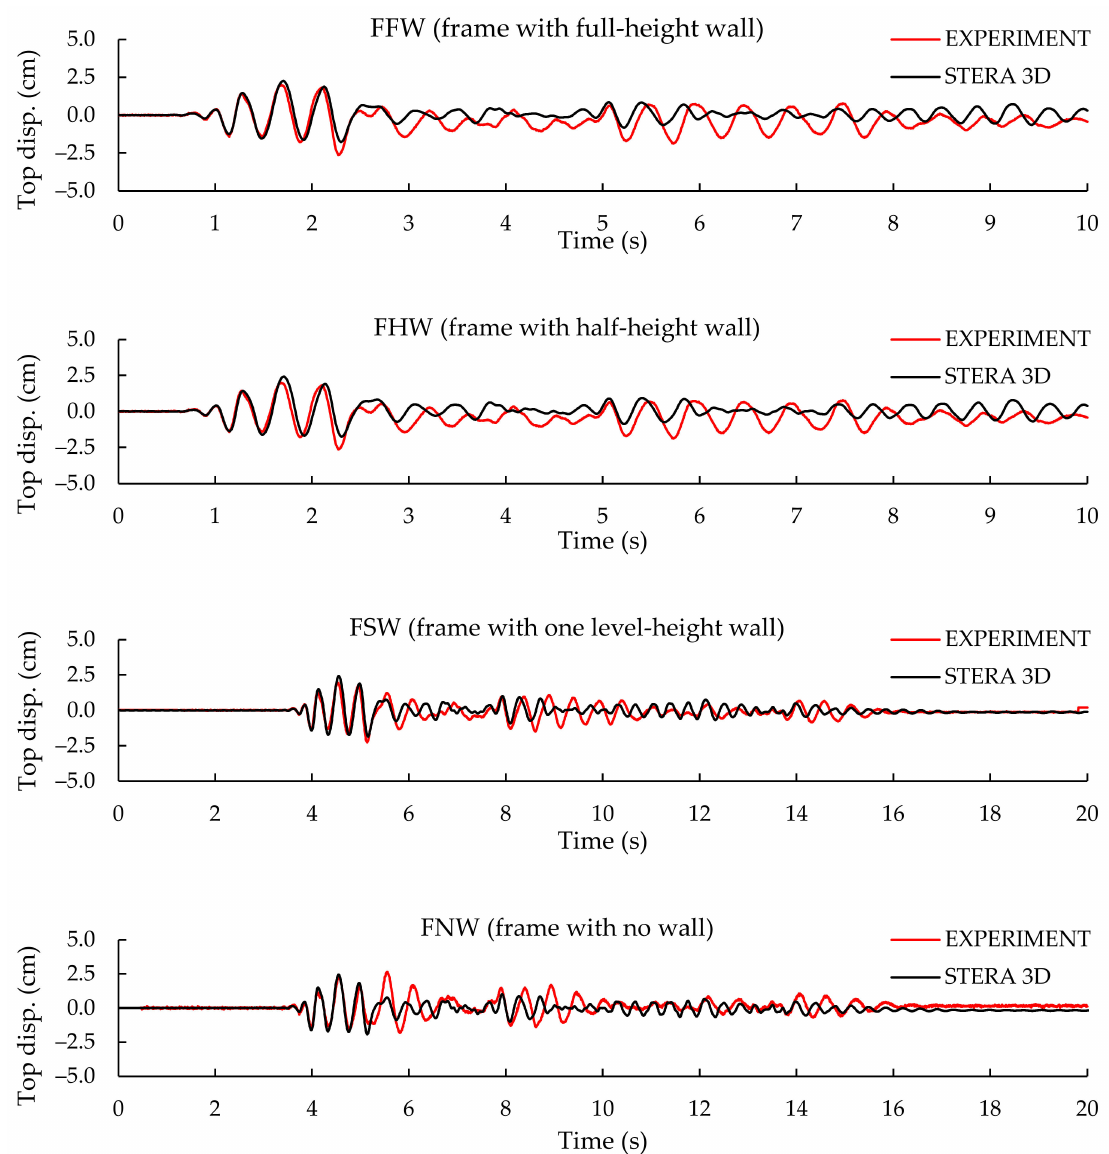
Figure 11. Comparison of displacement response between Experiment and STERA_3D